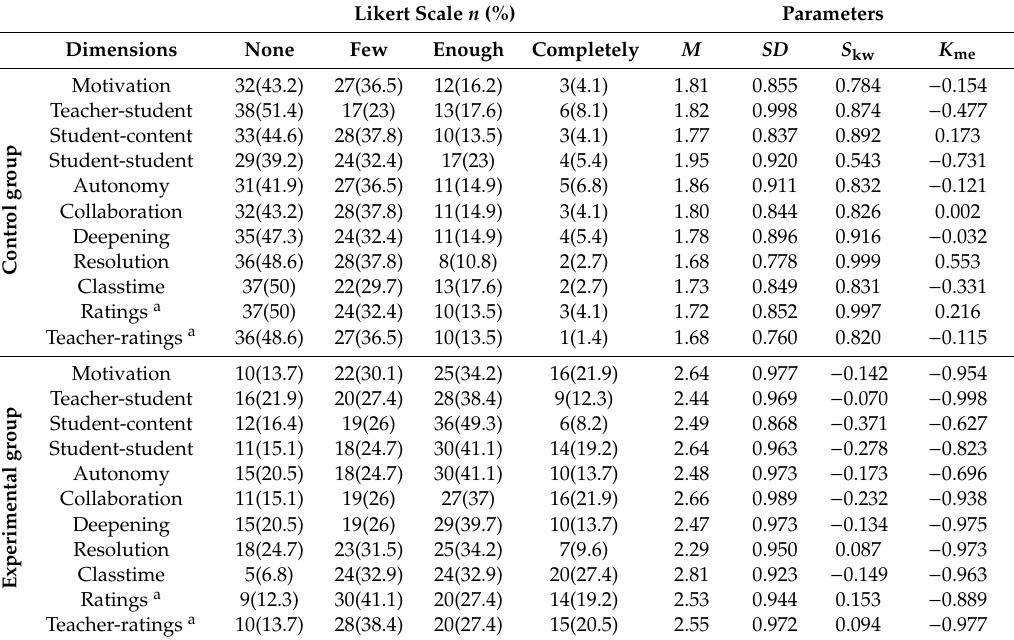
Table 2. Results obtained for the dimensions of study in CG and EG of students in Basic Vocational Training.